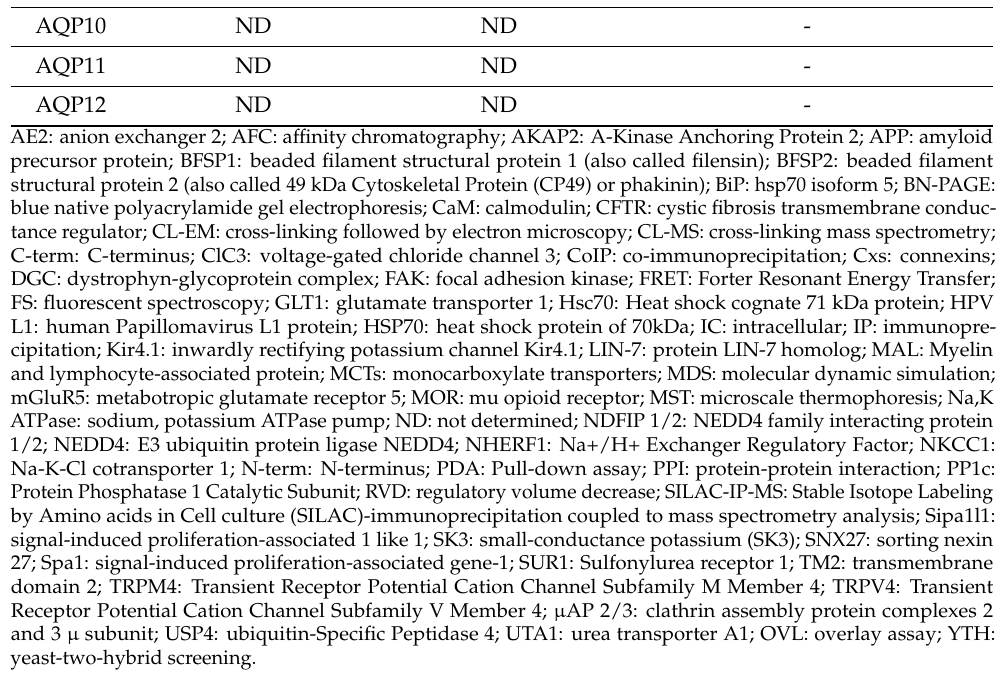
AQP Region Involved in PPI